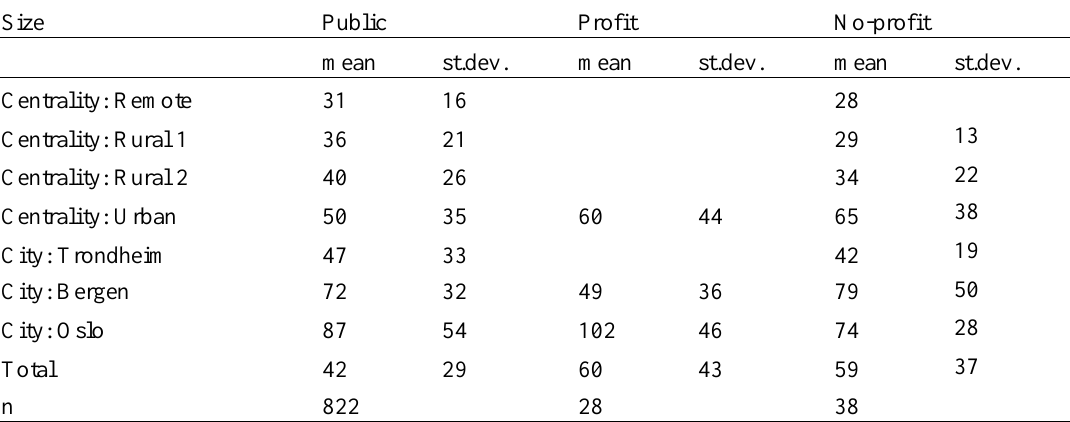
Table 4: Mean and standard deviation of size, by provider category and location (centrality and city) of the institutions Size Public